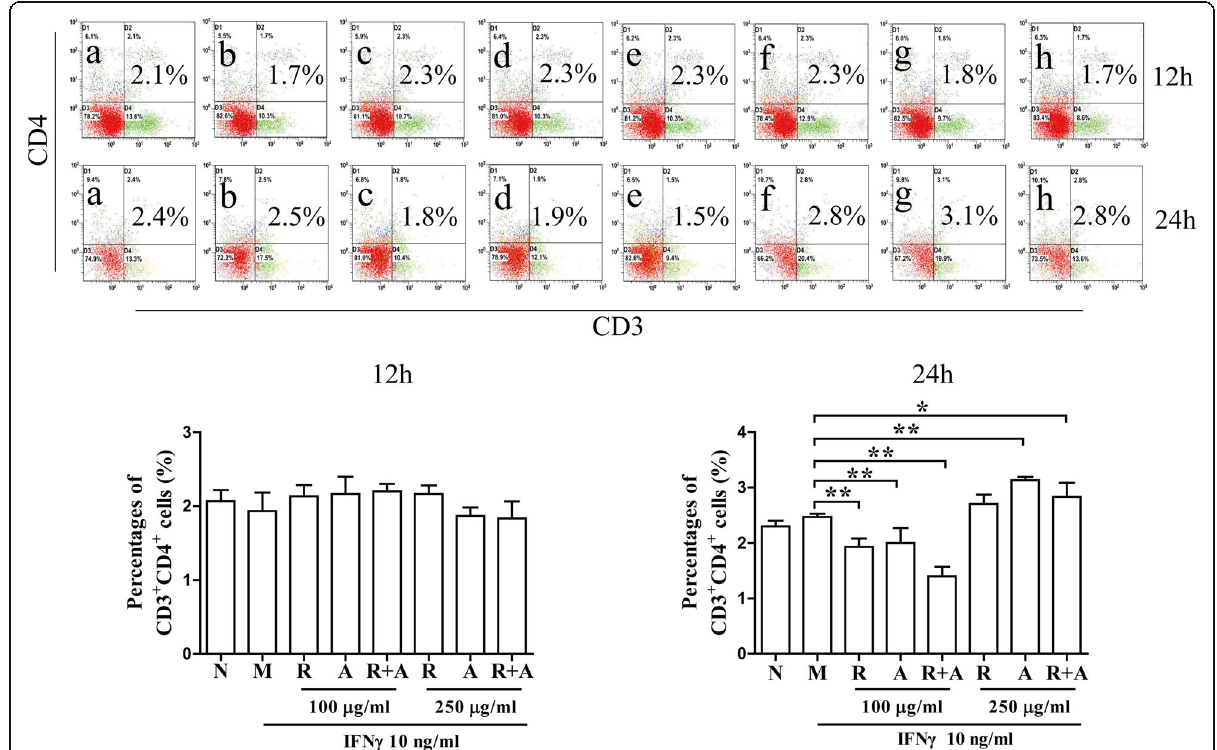
Fig. 3 Effects on the proliferation of CD3 + CD4 + T cells in BM cells after 12 and 24 h of treatment. The results are presented in bar charts. a, Normal (N) group; b, Model (M) group; c and f, Radix Astragali (R) group; d and g, Radix Angelicae Sinensis (A) group; e and h, Radix Astragali + Radix Angelicae Sinensis (R + A) group; c, d and e were treated with 100 μ g/mL of freeze-dried powders, and f, g and h were treated with 250 μ g/ mL of freeze-dried powders. The results are presented in a bar chart. Data are presented as the mean ± SD, n = 3. * P < 0.05 and ** P <